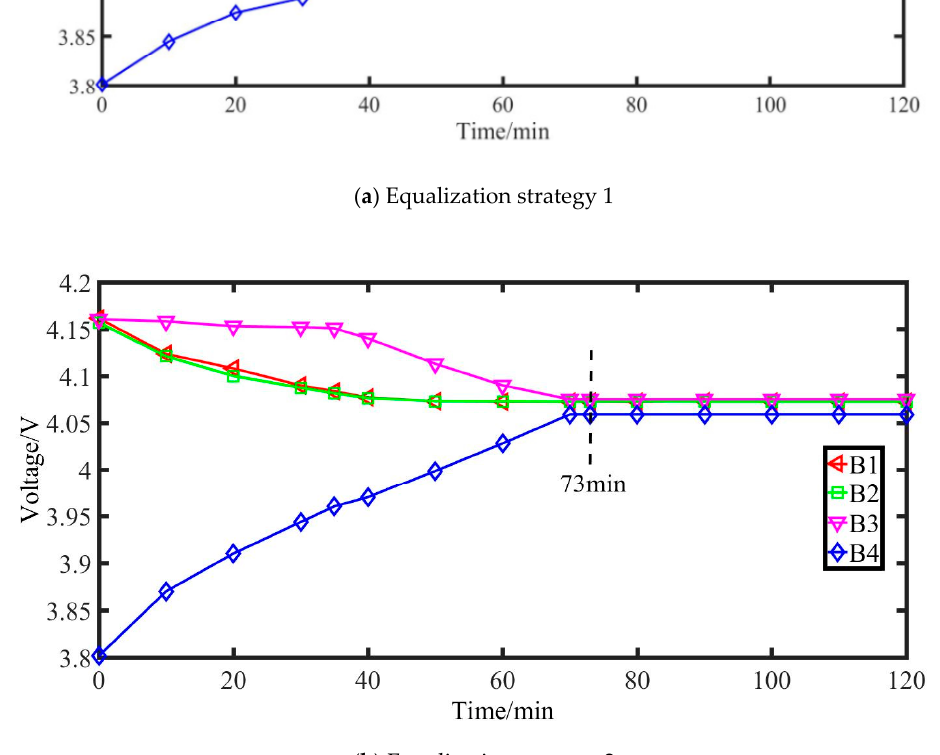
Figure 16. Experimental results of active equalization in static state.